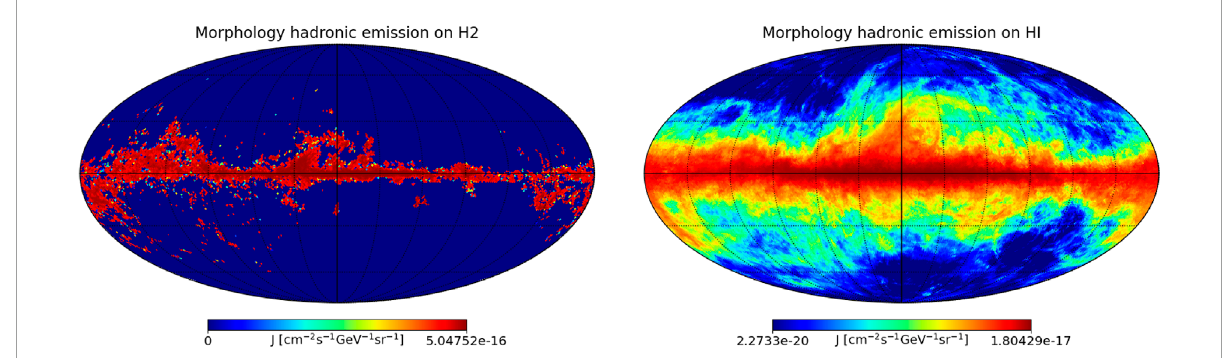
FIGURE 5 HEALPIX maps (NSIDE = 512) showing the morphology of the hadronic emission for 100 TeV γ -rays for the γ - optimized model (Min configuration). The left map shows the hadronic emission generated by the interactions of CRs with molecular (H2) gas, while the right map shows the hadronic emission generated by interactions of CRs with atomic (HI) gas. This distribution will be also followed by the ν emission.